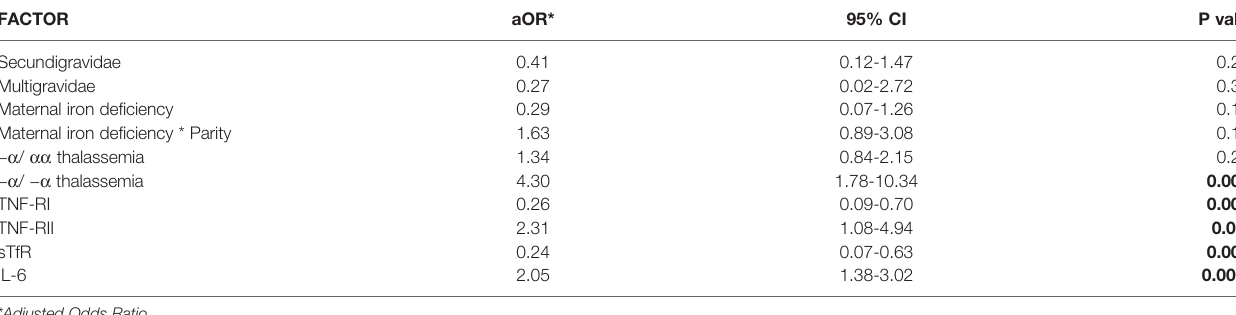
*Adjusted Odds Ratio. Bold values represent signi fi cant differences.